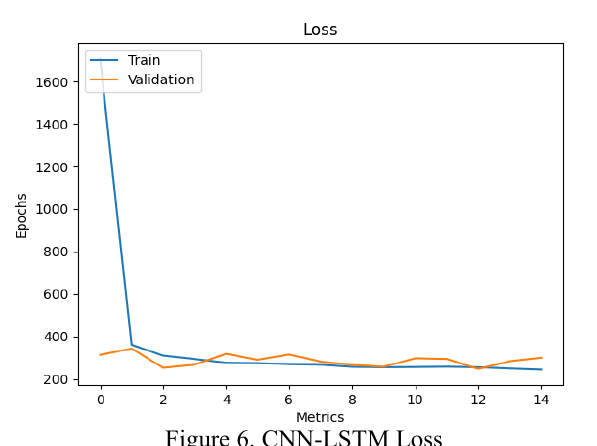
Figure 6. CNN-LSTM Loss The forecasting of the open price of TATASTEEL using CNN-LSTM model shows that its results are the best among the three models.